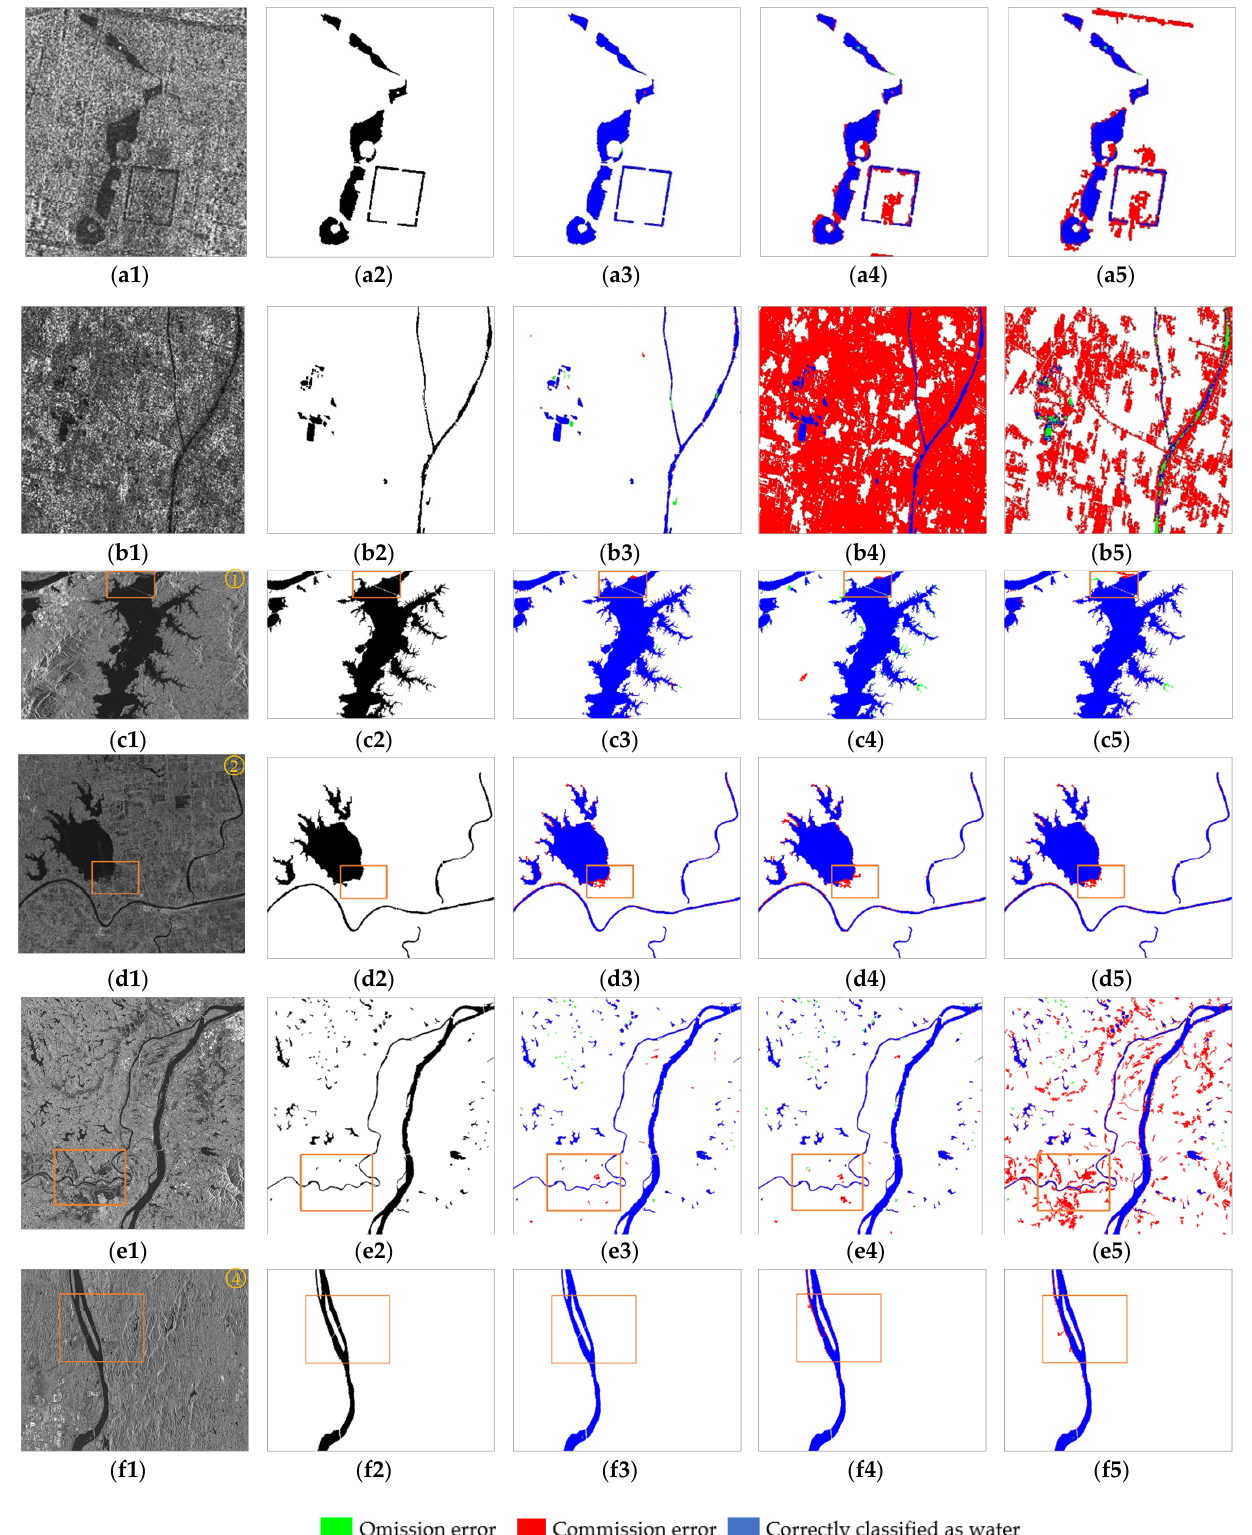
Figure 6. The water segmentation results by using different methods on dataset. ( a1 – f1 ) are the original images, ( a2 – f2 ) are the manually labeled ground truth. ( a3 – f3 ), ( a4 – f4 ), and ( a5 – f5 ) are the extraction outcomes of the proposed method, IGC method in [13], and IACM method in [14]. The highlighted colors in the results represent water (blue), omission error (green), and commission error (red).